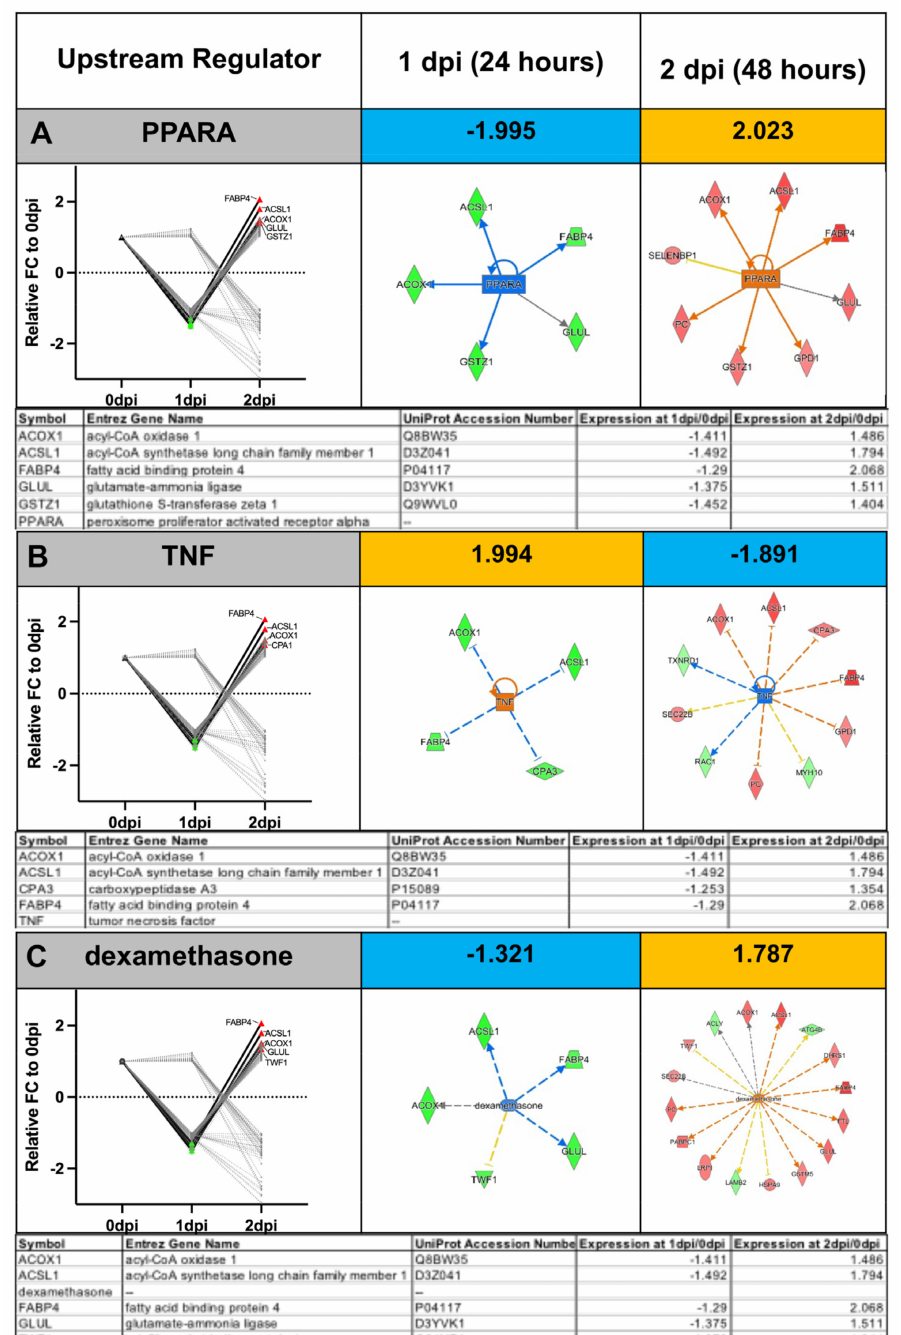
Figure A2. Trend-wise and compartmental dissection of expression trends highlight molecular dynamics within the axon through the injury-induced degeneration process. Top upstream regulators, ( A ) peroxisome proliferator-activated receptor alpha (PPARA) ( B ) tumour necrosis factor (TNF), and ( C ) dexamethasone exhibit opposing activation status (as indicated by +/ − z-score), mediating opposing directionality of target molecules between 1 dpi and 2 dpi following axotomy. Tables and graphs highlight relative expression of regulatory candidates through 1 dpi and 2dpi compared to 0 dpi as detected by proteomics study published in